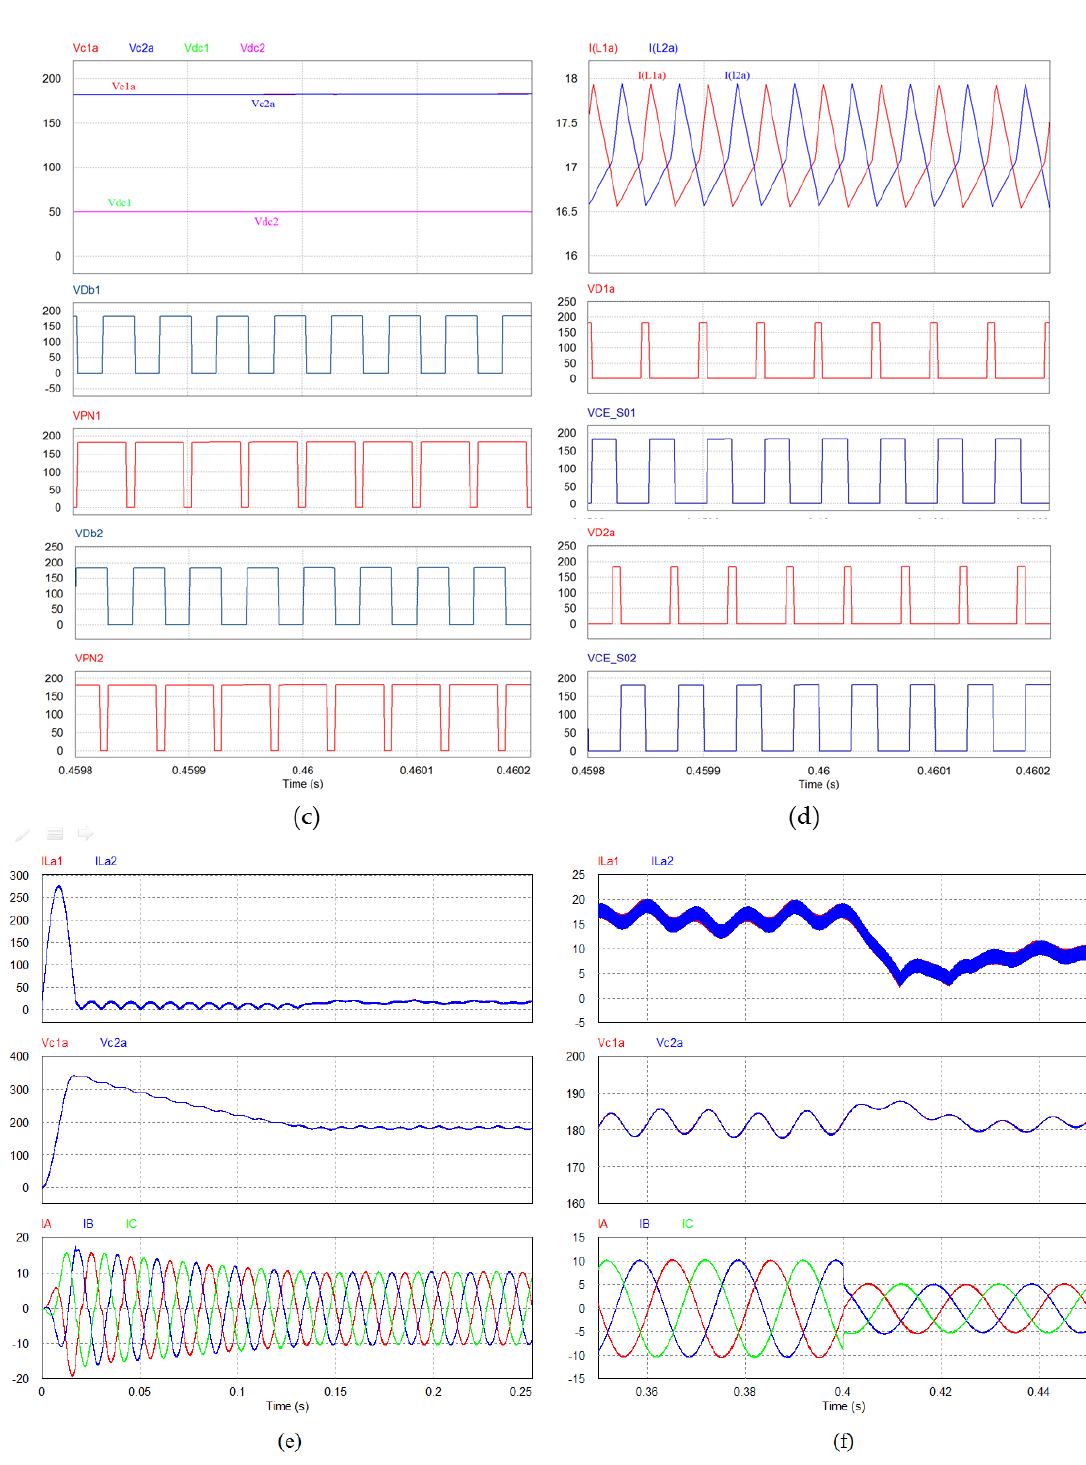
Figure 6. Simulation results for the CHB-qSBI when the input voltage V dc 1 = V dc 2 = 50 V. From top to bottom: ( a ) output line-to-line voltages, output phase voltages, and phase currents; ( b ) harmonic spectrum of output line-to-line voltages, harmonic spectrum of output phase voltages, and harmonic spectrum of phase currents; ( c ) input voltages, capacitors C 1 and C 2 voltages, diodes D b1 and D b2 voltages, and DC-link voltages; ( d ) inductor currents, diode D a1 voltage, switch S 01 voltage, diode D a2 voltage, and switch S 02 voltage of phase A; ( e , f ) inductor currents, capacitor voltages, and output phase current.